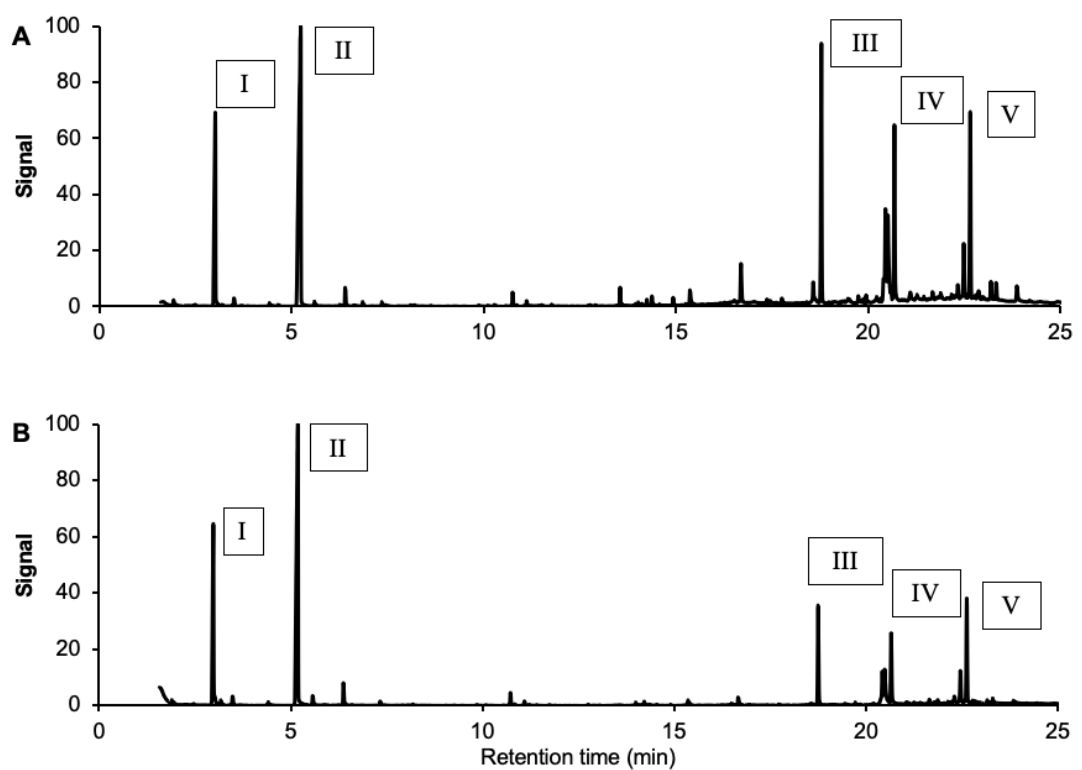
Figure 5. Chromatograms of PHA before ( A ) and after ( B ) purification. The identified compounds are: I—3-hydroxybutyric acid; II—3-hydroxyvaleric acid; III—Hexadecanoic acid; IV—Octadecanoic acid; V—Dehydroabietic acid.